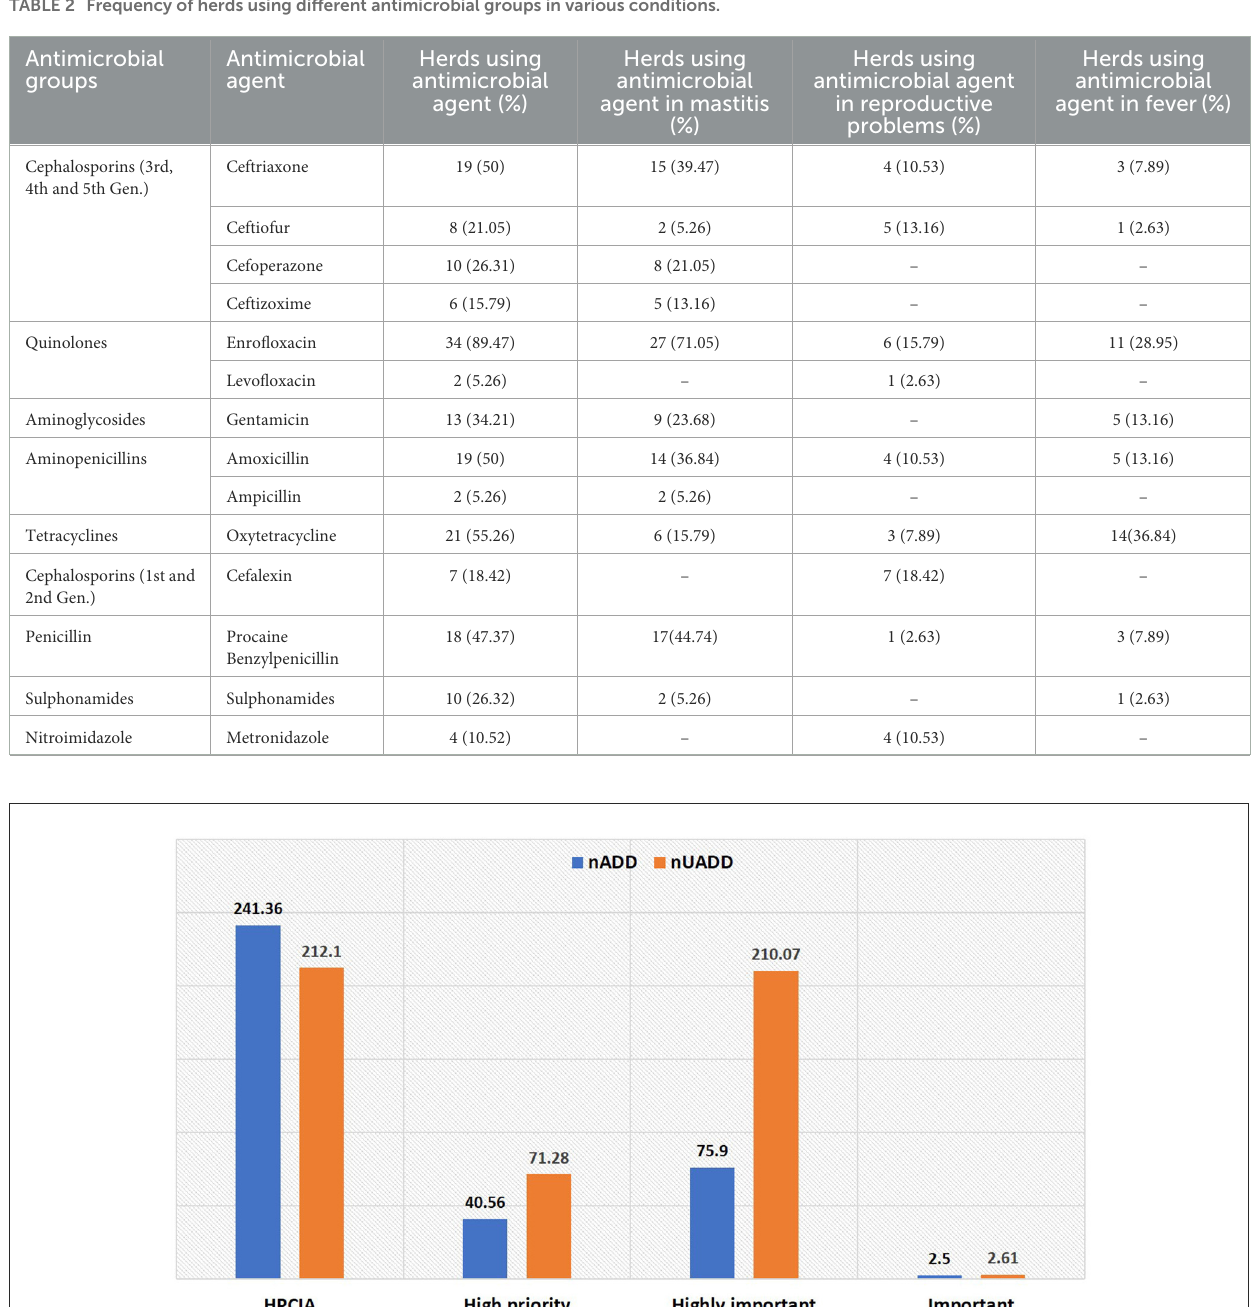
Antimicrobial agent